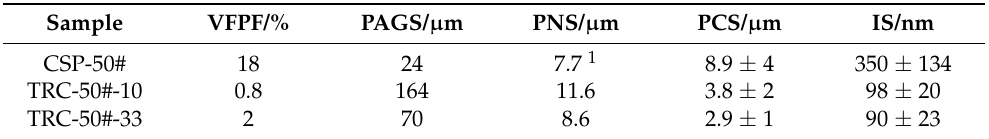
Figure 4. Optical micrographs of the hot-rolled strips. ( a ) CSP-50#. ( b ) TRC-50#-10. ( c ) TRC-50#-33. Table 4. Microstructural parameters of the three hot-rolled